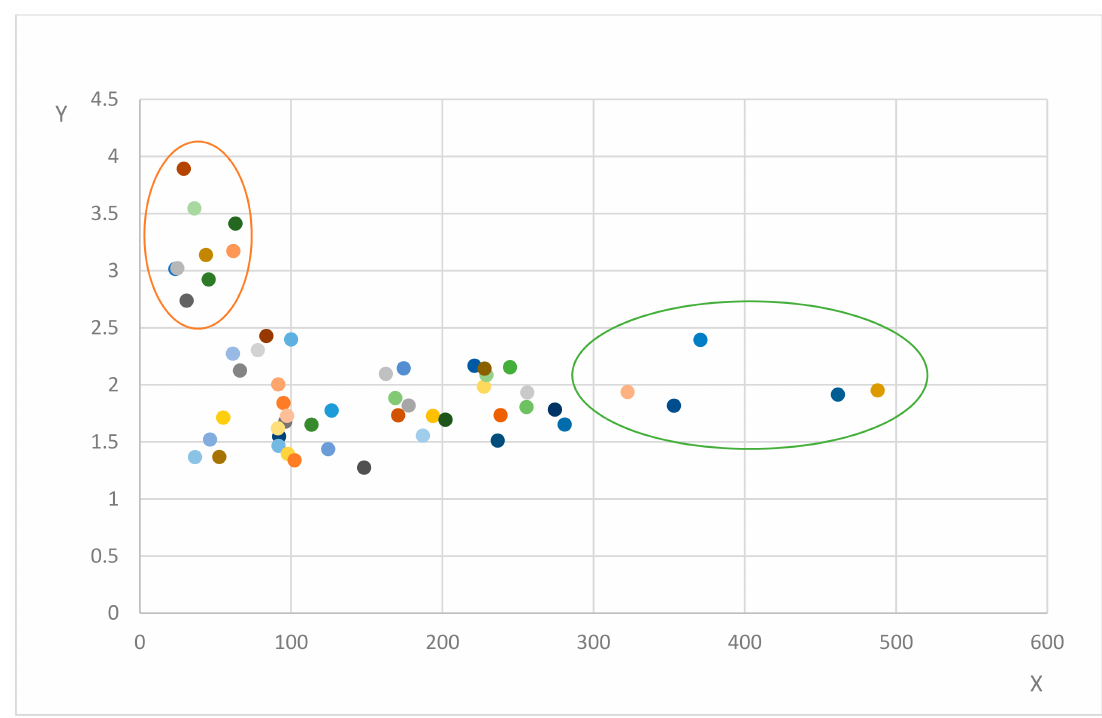
Figure 8. The total electrical power used in the settlement and by households—following the exclusion of two extreme factors. Legend: Axle Y = The amount of electricity provided to households (1000 kWh/household); Axle X = The total amount of electricity provided (1000 kWh/total consumers) ( n =